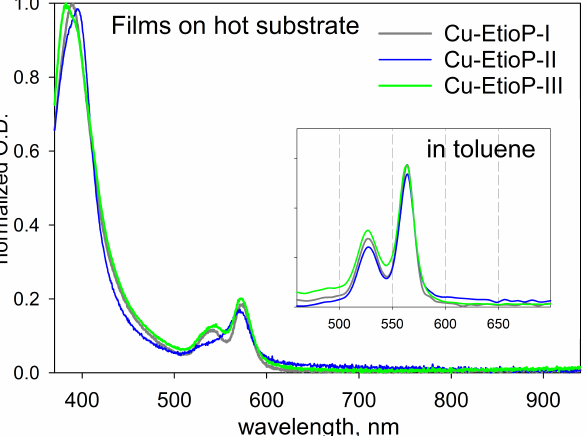
Figure 1. EAS of copper(II) etioporphyrin films on hot substrates, inset—spectra of solutions in toluene from